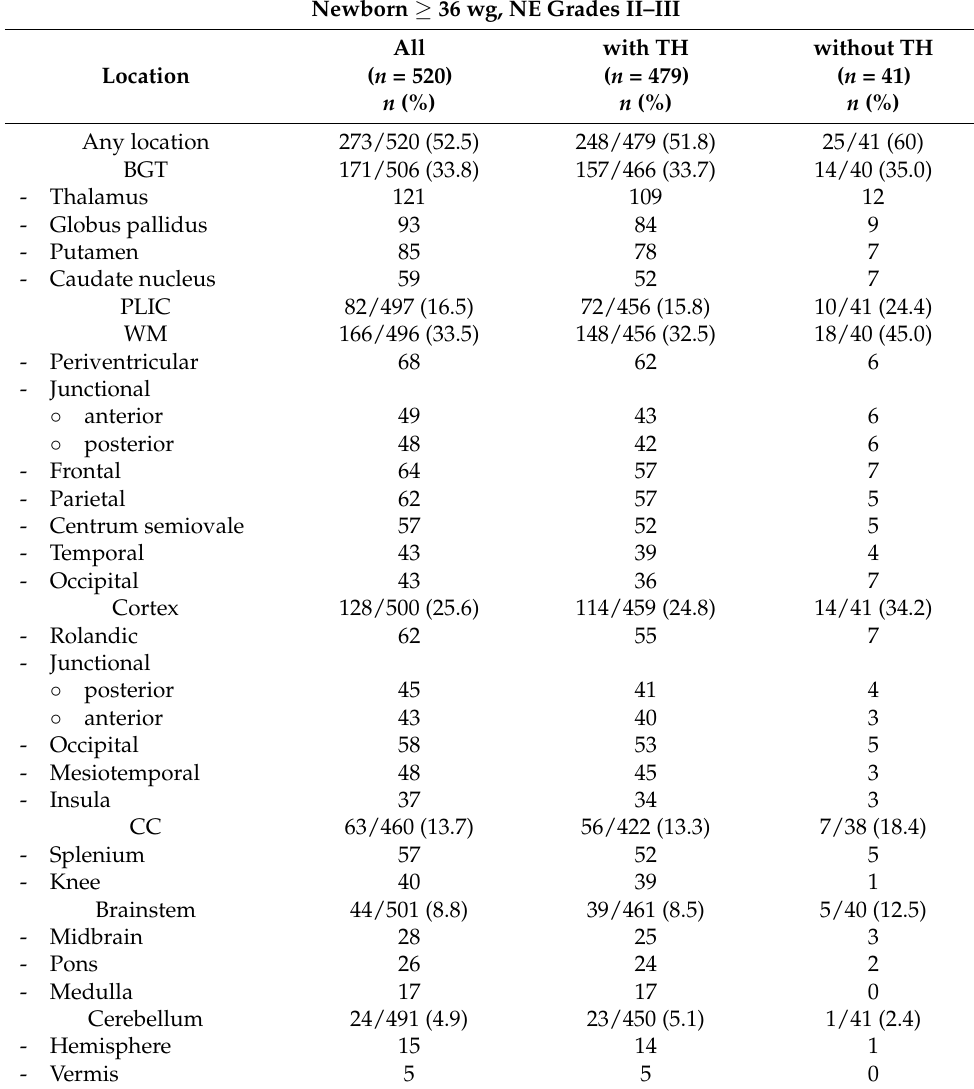
Abbreviations: NE = neonatal encephalopathy, grade I–II–III = stage of encephalopathy according to Sarnat classifi- cation [14], TH = therapeutic hypothermia, BGT = basal ganglia thalami, CC = corpus callosum, PLIC =